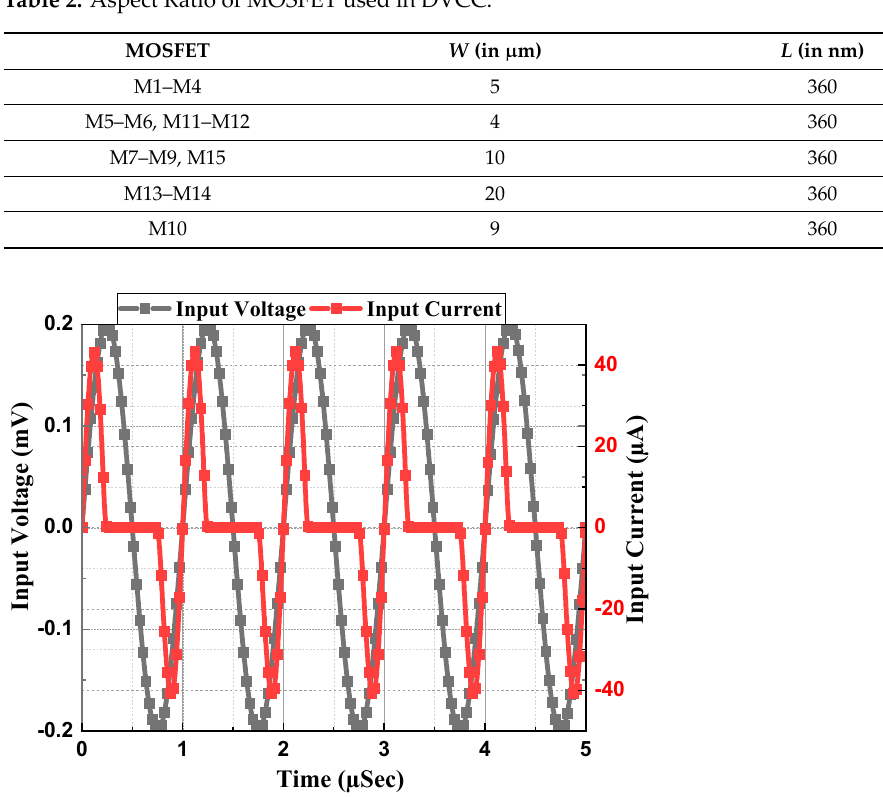
Table 2. Aspect Ratio of MOSFET used in DVCC.